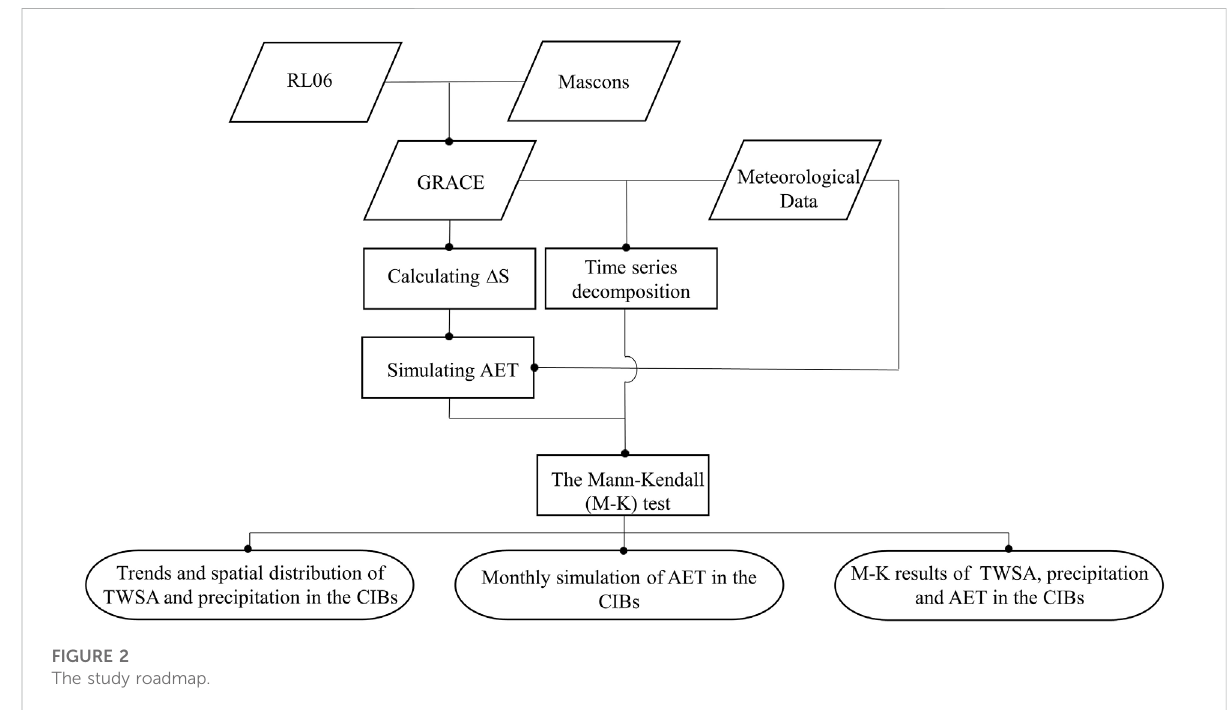
Figure 6 indicates the spatial distribution of precipitation trends in the CIBs from 2002 to 2020. Macroscopically, precipitation increased in the northeast, northwest